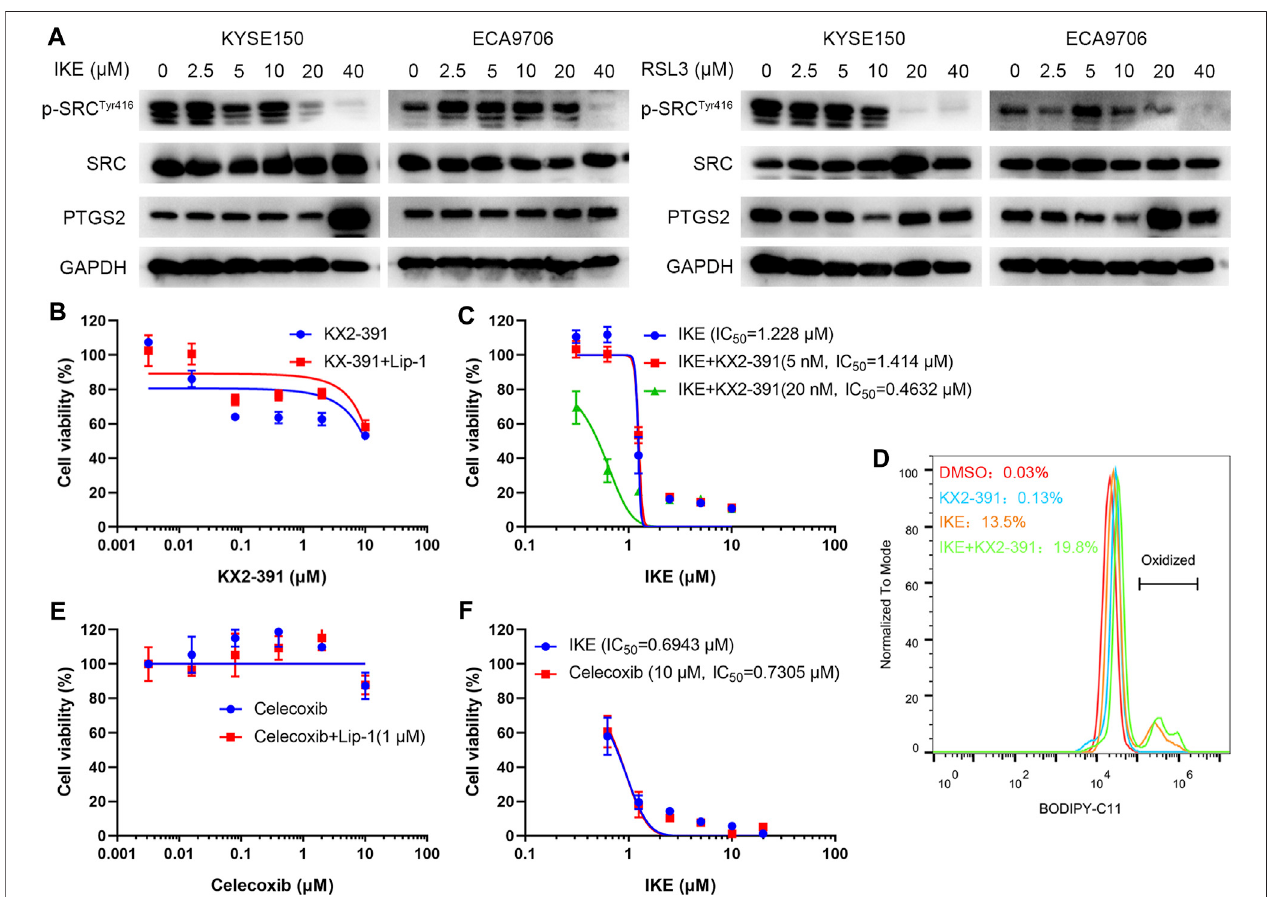
FIGURE11| SRCinhibitionsensitizesESCCcelllinetoferroptosis. (A) WesternblotanalysisofphosphorylatedSRC(Tyr416),SRCandPTGS2inESCCcellsafter treating with indicated concentration of IKE or RSL3 for 24 h. (B) Cell viability of ECA9706 cells was assessed after treating with either KX2-391, or KX2-391 and 1 μ M liproxstatin-1 for 48 h. (C) Dose-dependent toxicity of IKE in ECA9706 cells with or without KX2-391 presence. (D) Flow cytometry analysis of IKE-induced (2.5 μ M for 18 h) BODIPY 581/591 C11 oxidization in ECA9706 cells treated with or without KX2-391. (E) Cell viability was assessed in ECA9706 cells following treating with Celecoxib, or Celecoxib and liproxstatin-1 (1 µM, 48 h). (F) Dose-dependent toxicity of IKE in ECA9706 cells with or without Celecoxib